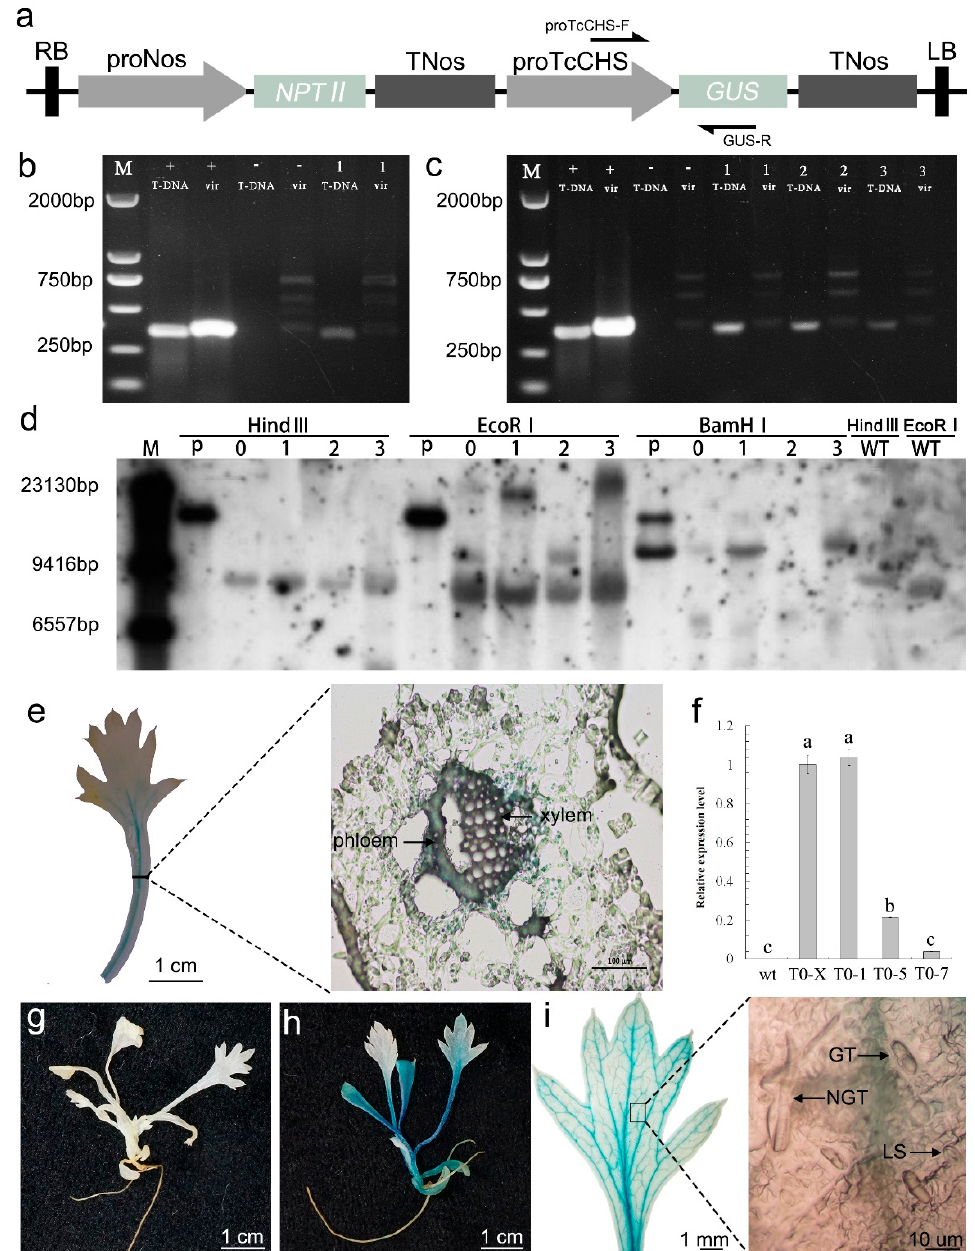
Figure 3. Molecular analysis of transgenic proTcCHS-GUS pyrethrum plants. ( a ) Schematic structure of the proTcCHS-GUS vector and primer locations (arrows). ( b ) Agarose gel image of PCR products showing amplification of the proTcCHS-GUS and VirG gene from genomic DNA of T0-X. M: marker; +: EHA105 harboring proTcCHS-GUS vector; − : control from nontransformed plants; 1: T0-X; T-DNA: proTcCHS-F and GUS-R were used for PCR; vir : VirG-F and VirG-R were used for PCR. ( c ) Agarose gel image of PCR products showing amplification of the proTcCHS-GUS gene and VirG gene from genomic DNA of T0-1, T0-5, and T0-7. M: marker; +: EHA105 harboring proTcCHS-GUS vector; − : control from nontransformed plants; 1: T0-1; 2: T0-5; 3: T0-7; T-DNA: proTcCHS-F and GUS-R were used for PCR; vir : VirG-F and VirG-R were used for PCR. ( d ) Southern blot of T0-X, T1-1, T1-5, and T1-7. M: marker; P: proTcCHS-GUS vector; WT EcoRI: control from nontransformed plants; 0: T0-X; 1: T1-1; 2: T1-5; 3: T1-7. ( e ) Histochemical staining and petiole slice of T0-X. ( f ) Reverse-transcription quantitative PCR analysis of GUS expression in T0-X, T0-1, T0-5, and T0-7. Bars indicate the mean ± SD. Bars with a different lower-case letter are significantly different (LSD test, p < 0.05). ( g ) Histochemical staining of nontransformed plants. ( h ) Histochemical staining of kanamycin-resistant seedlings. ( i ) Enlarged view of stained leaf. GT: capitate glandular trichomes; NGT: T-shaped nonglandular trichomes; LS: leaf